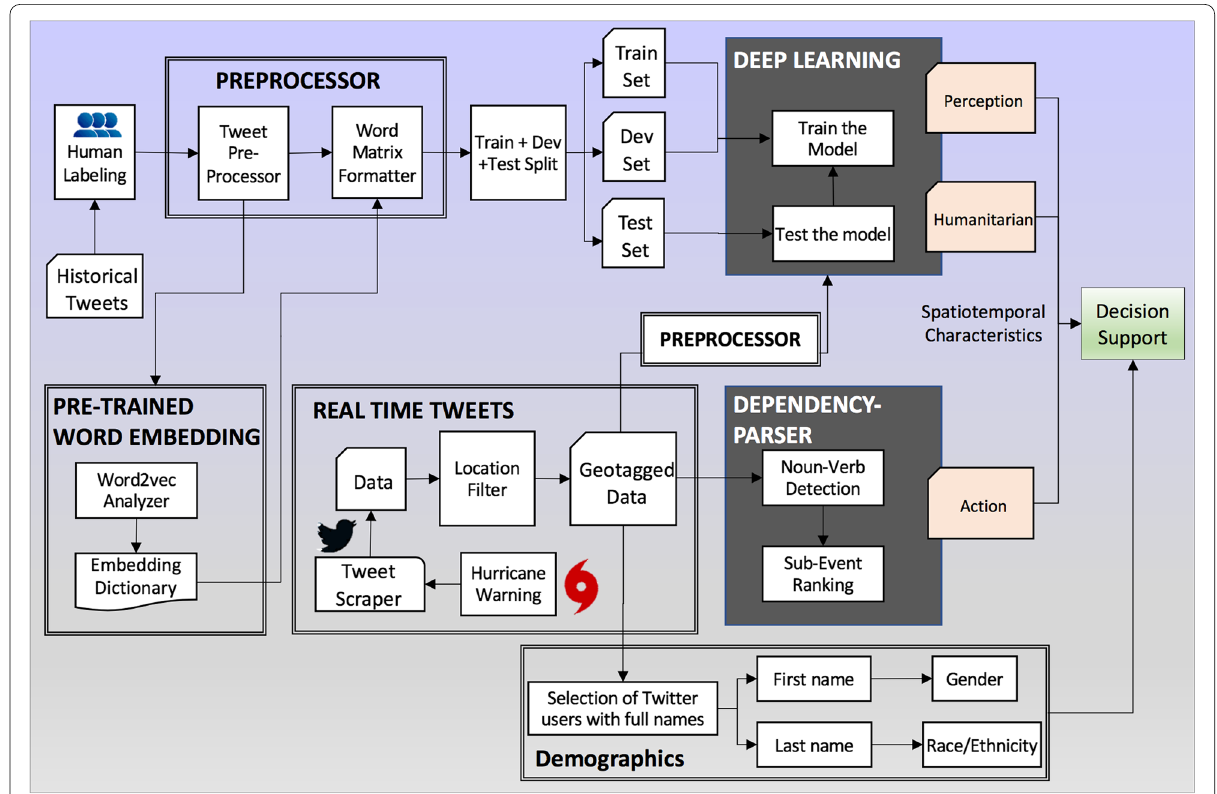
Fig. 2 The framework for multi-level situational awareness